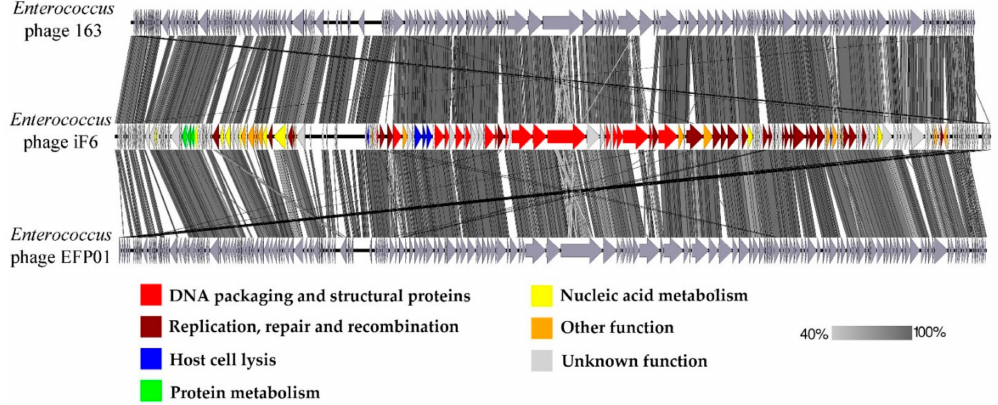
Figure 7. The pairwise whole-genome tBLASTx comparison of iF6 and the most closely related phages. The iF6 ORFs are colored according to their general function (see the color scheme at the bottom). Gray areas between the genome maps indicate the level of identity in the range of 40% to 100% (see the gradient scheme on the right).